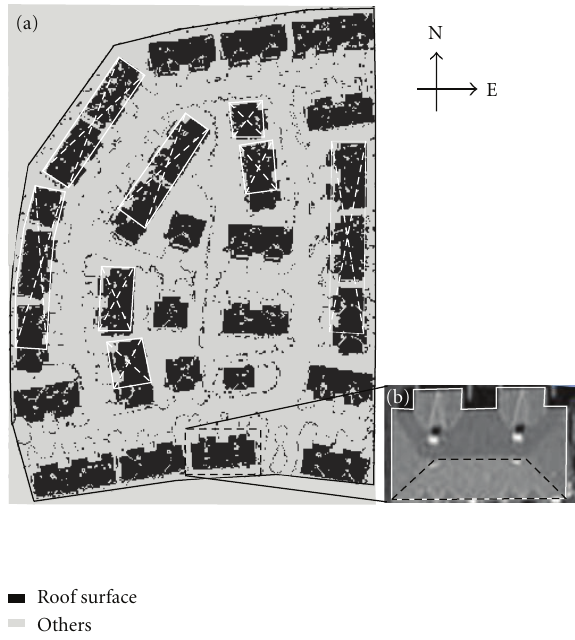
Figure 3: (a) Classification of the remote sensing image into two classes of (i) roof surface; and (ii) others within the area of interest denoted by black polygon. The roof surfaces under the white crosses with the white rectangles were excluded from further consideration (asthere were notoriented to either south or south-westdirections). (b) an extended view of a roof surface, where the dotted black boxed area was only considered as suitable for harvesting the greatest amount of incident solar